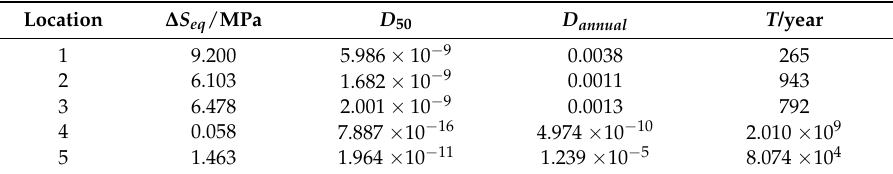
Table 2. Fatigue assessment result based on equivalent structural stress